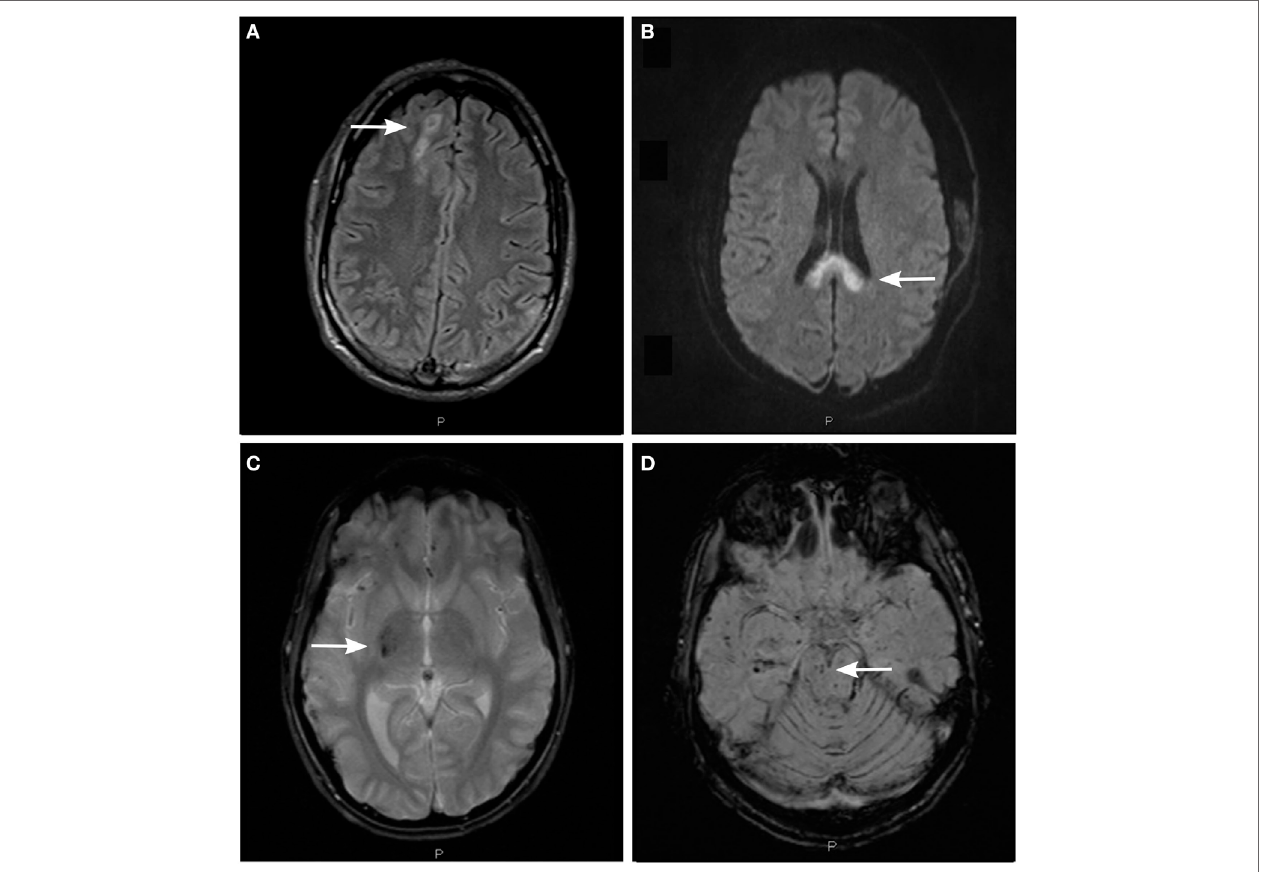
FiGURe 2 | Detection of axonal injury with conventional magnetic resonance imaging (MRI) using different MRI sequences. (A) Fluid-attenuated inversion recovery (FLAIR) image depicting non-hemorrhagic diffuse axonal injury (DAI)-associated lesions in the subcortical white matter of the right cerebral hemisphere (arrow). (B) Diffusion-weighted image (DWI) depicting non-hemorrhagic DAI-associated lesions in the body and splenium of the corpus callosum. (C) T2*-weighted gradient echo (T2*GRE) image depicting hemorrhagic DAI-associated lesions in the right thalamus and putamen (arrow). (D) Susceptibility-weighted image (SWI) depicting hemorrhagic DAI-associated lesions in the right mesencephalon (arrow) and in the white matter of right temporal lobe.